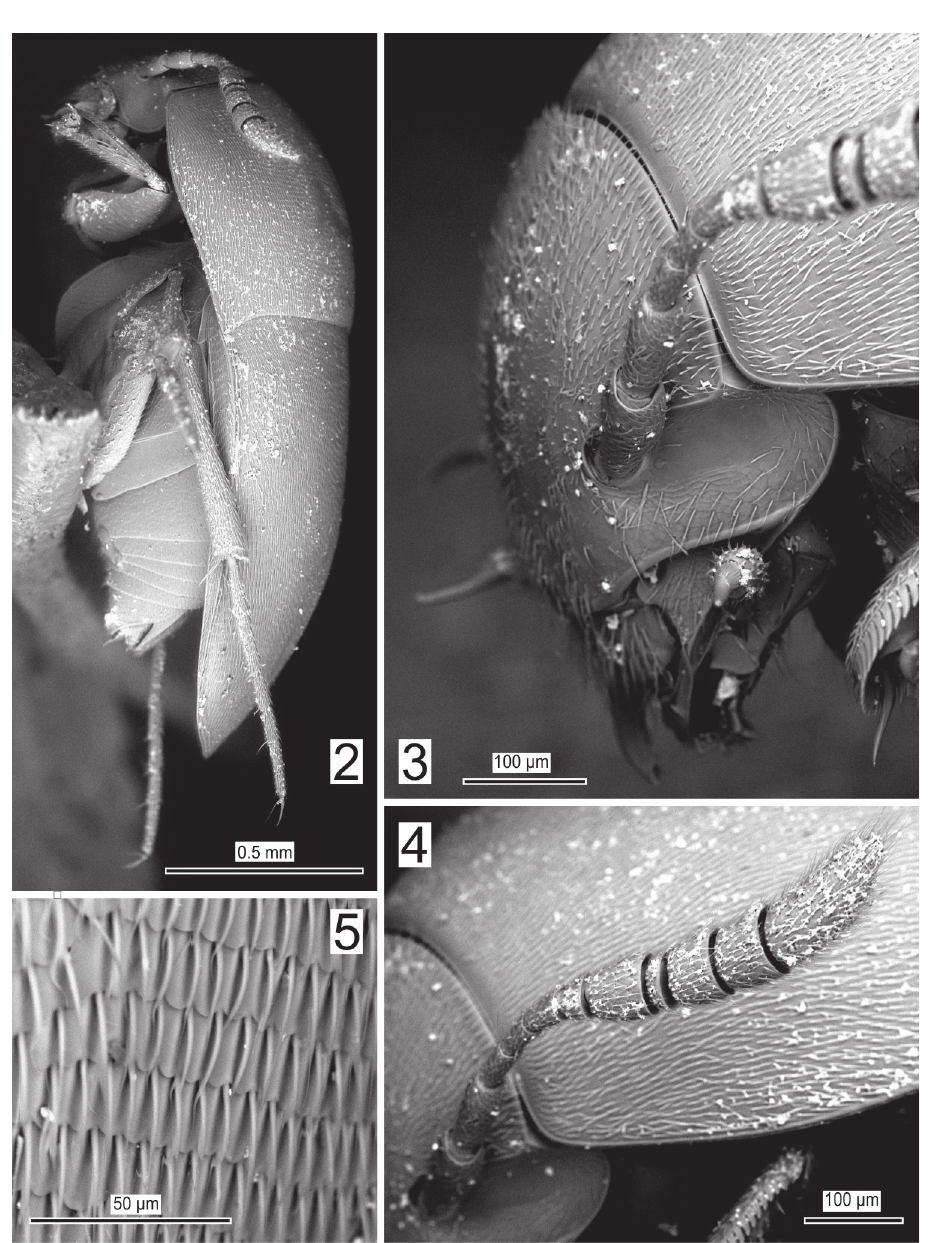
Figures 2–5. Ptomaphaginus troglodytes sp. n., male holotype from Shuiboshu Dong cave, SEM. 2 habi- tus laterally 3 head laterally 4 left antenna 5 surface of left